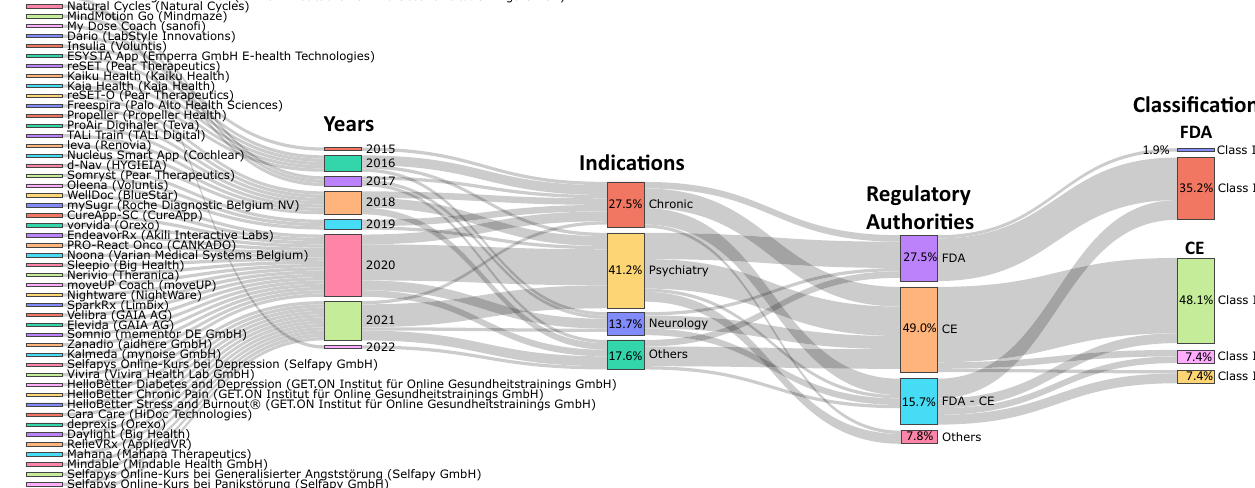
Fig. 2 Sankey diagram depicting the major indications and regulatory status of commercial digital therapeutics. Sankey diagrams were employed to analyze trends in the types of indications, regulatory agency types, and class types for commercial digital therapeutic devices. The investigation focused on products listed on the DTA, DiGA, and mhealthbelgium websites, as well as products that had received FDA approval listed in the FDA medical device database. Regulatory authorities for each product were also investigated. Commercial digital therapeutics are primarily launched for indications related to chronic conditions, psychiatry, and neurology, with additional products available for urinary incontinence, ear disorders, hip and knee arthroplasty, tinnitus, irritable bowel syndrome, and vaginismus. Most commercial products have received approval from the FDA and CE regulatory agencies, while others have been approved by Japan ’ s Ministry of Health, Labour and Welfare (MHLW) and the Medicines and Healthcare products Regulatory Agency